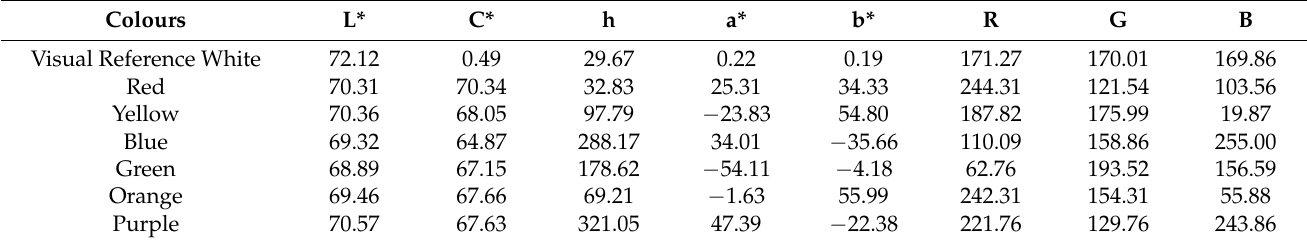
Table A2. The characteristics of the background colours within the VR